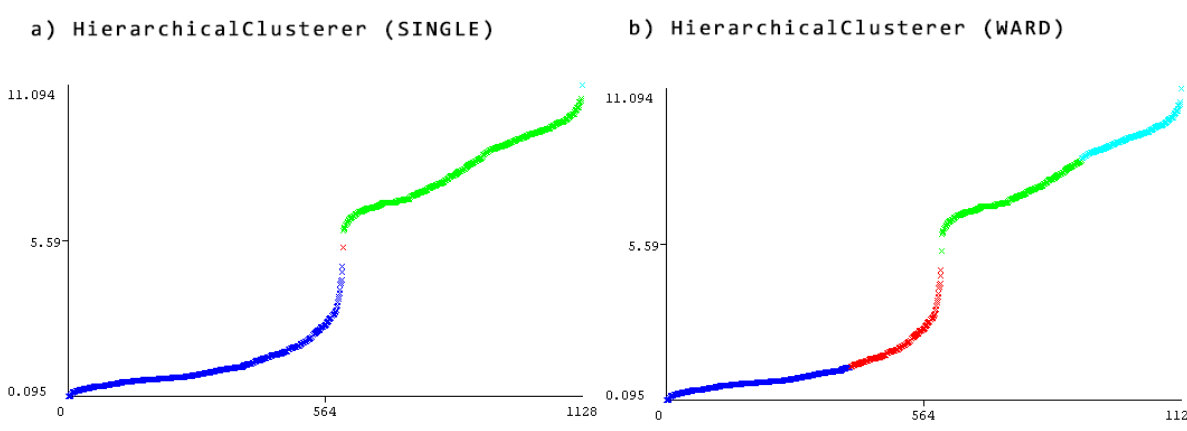
Figure 3. ln(x+1) clustering by HierarchicalClusterer (x=Ni concentration data expressed in ppm). Four clusters are observed: cluster 0 (blue), cluster 1 (red), cluster 2 (green) and cluster 3 (cyan). Y-axis shows the value of ln(x+1), whereas X-axis shows the number of the instance (the order of Ni datum in the original data file, where values were ordered from lowest to